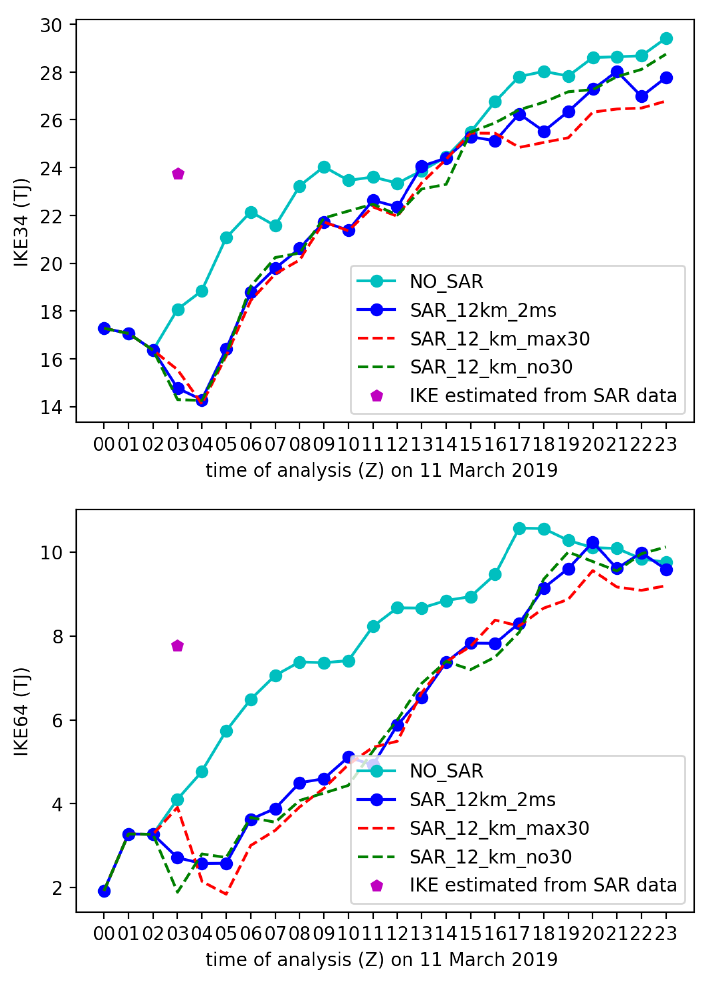
Figure 22. Evolution of IKE34 and IKE64 in the analyses of 11 March 2019 for NO_SAR, SAR_12km_2ms, SAR_12km_max30,